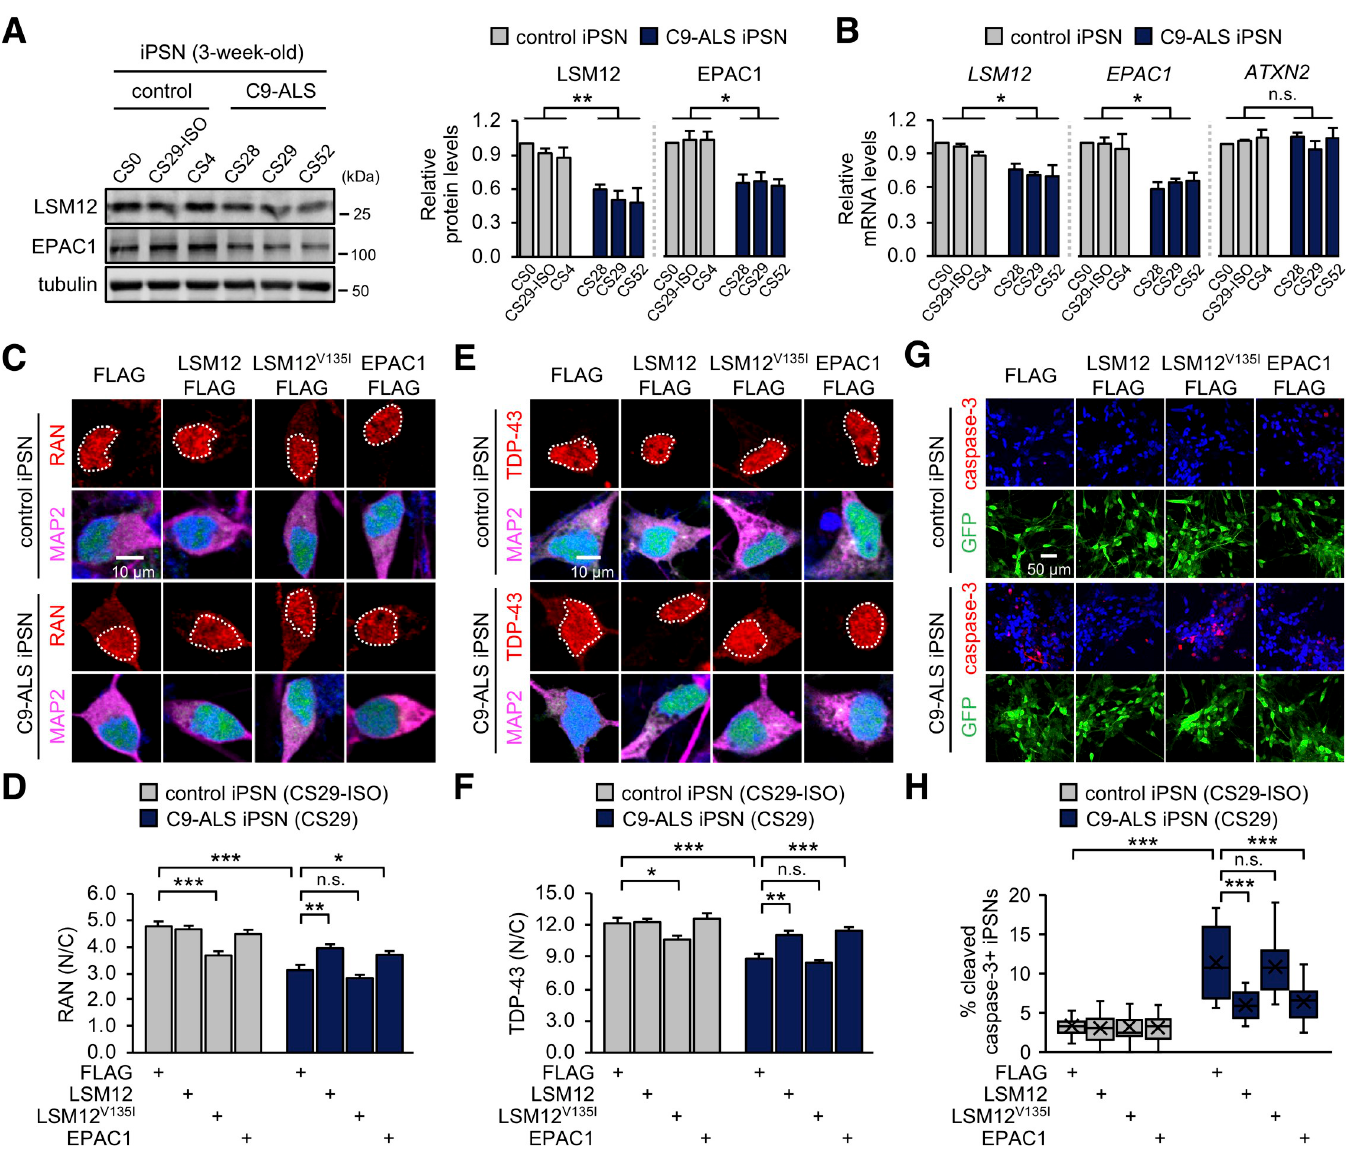
Fig 7. Overexpression of LSM12 or EPAC1 rescues NCT-relevant pathologies in C9-ALS patient-derived neurons. (A) C9-ALS iPSNs express low levels of LSM12 and EPAC1 proteins. C9-ALS iPSNs (CS28, CS29, and CS52) and control iPSNs (CS0, CS29-ISO, CS4) were harvested 21 days after neuronal differentiation from NPCs. Total cell extracts from 3-week-old iPSNs were resolved by SDS-PAGE and immunoblotted with anti-LSM12, anti-EPAC1, and anti-tubulin (loading control) antibodies. The abundance of each protein was quantified as in Fig 1C. Error bars indicate SEM ( n = 3 independent differentiation experiments). � P < 0.05, �� P < 0.01, as determined by 1-way ANOVA with Dunnett post hoc test. (B) C9-ALS iPSNs express low levels of LSM12 and EPAC1 transcripts. Total RNA was prepared from 3-week- old iPSNs, and the abundance of each transcript was quantified as in Fig 5B. Data represent means ± SEM ( n = 3 independent differentiation experiments). n.s., not significant; � P < 0.05, as determined by 1-way ANOVA with Dunnett post hoc test. (C, D) Overexpression of LSM12 or EPAC1 rescues the RAN gradient in C9-ALS iPSNs. NPCs from C9-ALS iPSCs (CS29) and their isogenic control cells (CS29-ISO) were transduced with individual recombinant lentiviruses that express the indicated FLAG-tagged proteins along with a GFP reporter. iPSNs were fixed 21 days after neuronal differentiation from NPCs and co-stained with anti-RAN antibody (red), anti- MAP2 antibody (magenta), and Hoechst 33258 (blue). The nucleocytoplasmic RAN gradient was quantified as in Fig 2D. Two-way ANOVA detected significant interaction effects of C9-ALS and lentiviral overexpression on the RAN gradient ( P = 0.0051 for LSM12; P = 0.0066 for LSM12 V135I ; P = 0.0041 for EPAC1). Data represent means ± SEM ( n = 100–105 GFP–positive cells from 4 independent differentiation experiments). n.s., not significant; � P < 0.05, �� P < 0.01, ��� P < 0.001, as determined by Tukey post hoc test. (E, F) Overexpression of LSM12 or EPAC1 suppresses the pathogenic mislocalization of TDP-43 in the cytoplasm of C9-ALS iPSNs. Three-week-old iPSNs (CS29-ISO and C9-ALS CS29) were co-stained with anti-TDP-43 antibody (red), anti-MAP2 antibody (magenta), and Hoechst 33258 (blue). The relative distribution of endogenous TDP-43 proteins was quantified similarly as above. Two-way ANOVA detected significant interaction effects of C9-ALS and lentiviral overexpression on the RAN gradient ( P = 0.0154 for LSM12; P = 0.0120 for EPAC1). Data represent means ± SEM ( n = 102–104 GFP–positive cells from 4 independent differentiation experiments). n.s., not significant; � P < 0.05, �� P < 0.01, ��� P < 0.001, as determined by 2-way ANOVA with Tukey post hoc test. (G, H) Overexpression of LSM12 or EPAC1 suppresses caspase-3 activation in C9-ALS iPSNs. Three-week-old iPSNs (CS29-ISO and C9-ALS CS29) were co-stained with anti-cleaved caspase-3